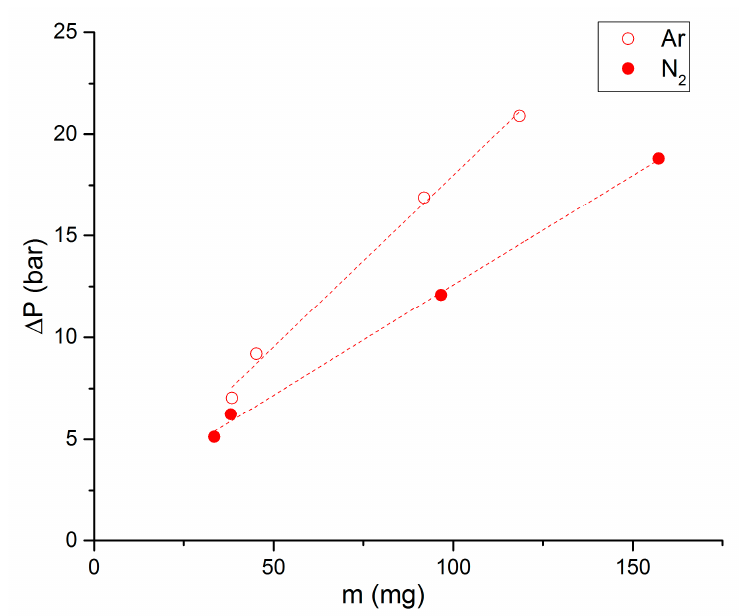
Molecules 2020 , 25 , x FOR PEER REVIEW Figure 9. Overpressure as a function of initial mass, propellant 90-10, initial pressure of 50 bar.